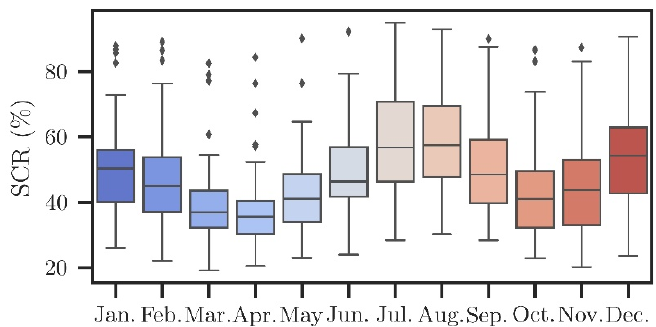
Figure 4. Monthly SCR values of the analyzed households (n = 55).